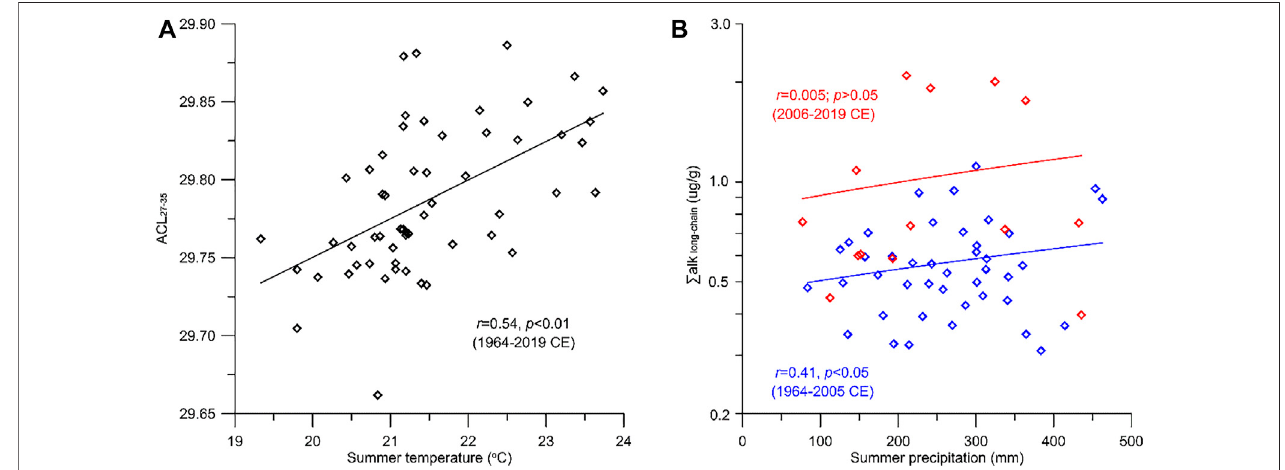
FIGURE 6 | Correlation coef fi cient results. (A) Summer temperature and ACL 27 – 35 ; (B) summer precipitation and (cid:1) alk long-chain .